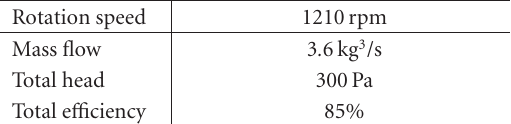
Figure 1: View of the axial compressor. Table 1: Machine global